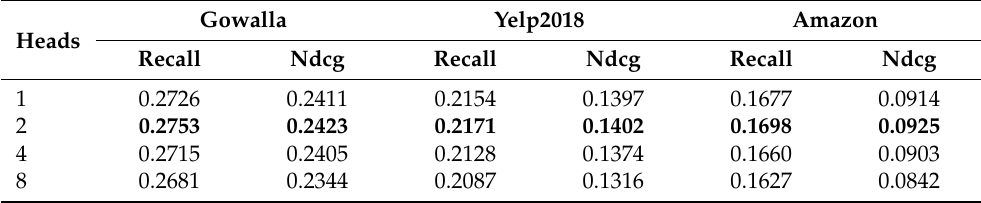
Table 3. Effect of graph attention network with different number of heads on performance.